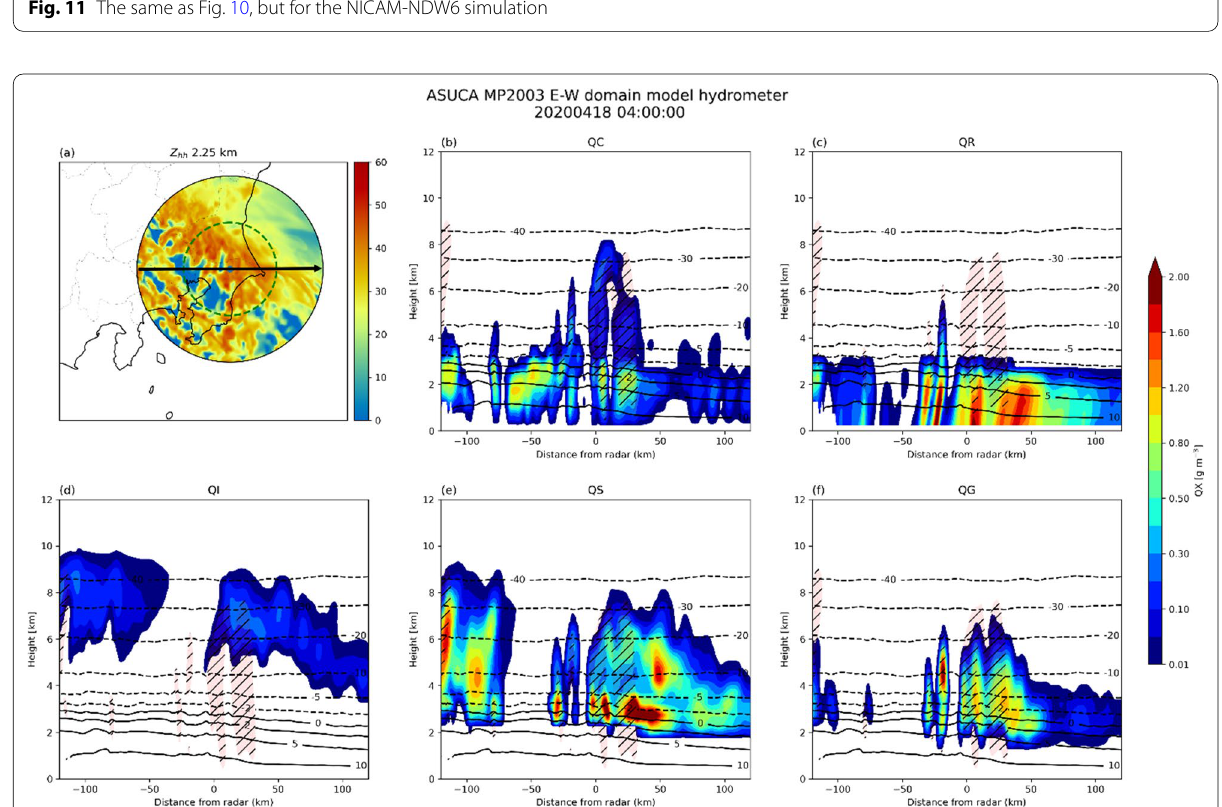
Fig. 12 The same as Fig. 10, but for the ASUCA